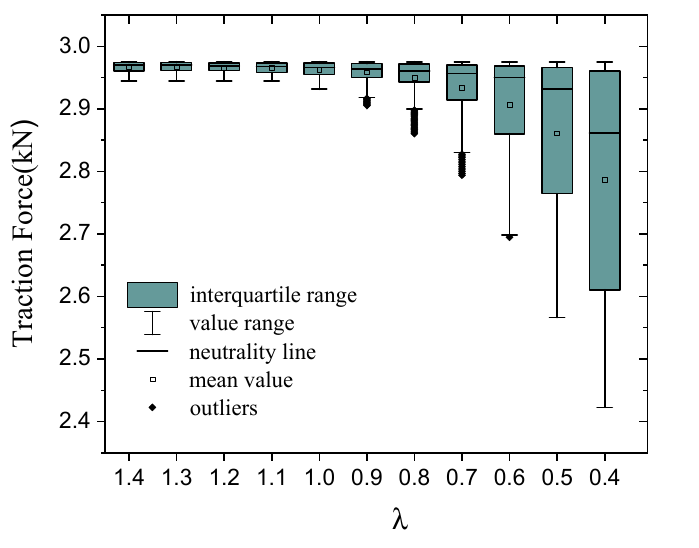
Figure 13. Fluctuant of dynamic traction.